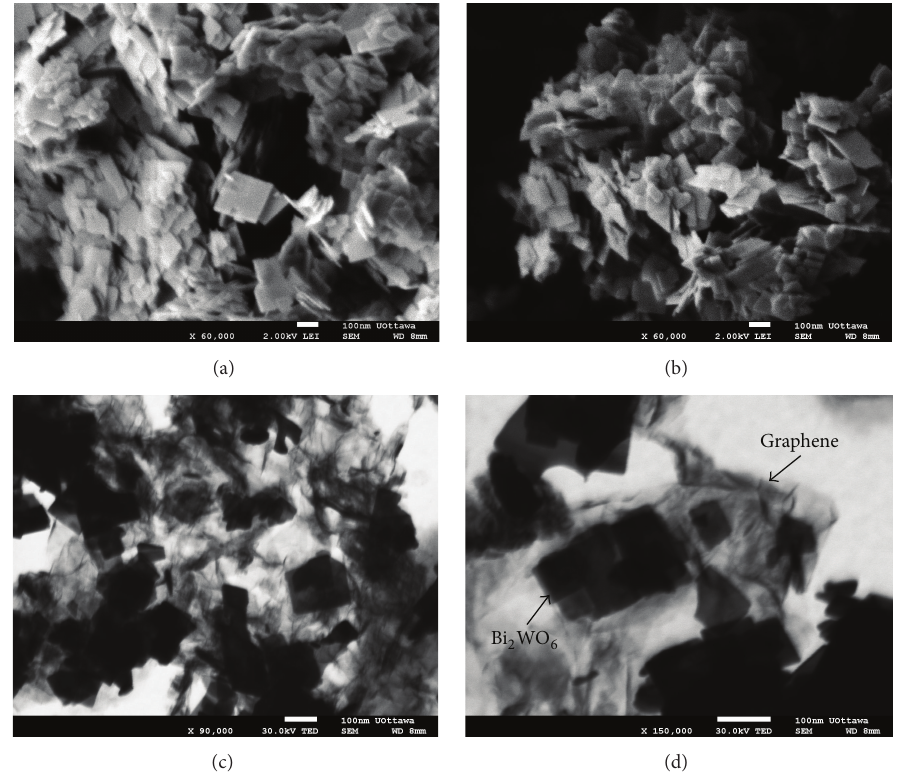
Figure 2: SEM images of (a) pure Bi 2 WO 6 and (b) 1.2% G-BWO composite and STEM images of 1.2% G-BWO composite in low (c) and high (d) magnification.